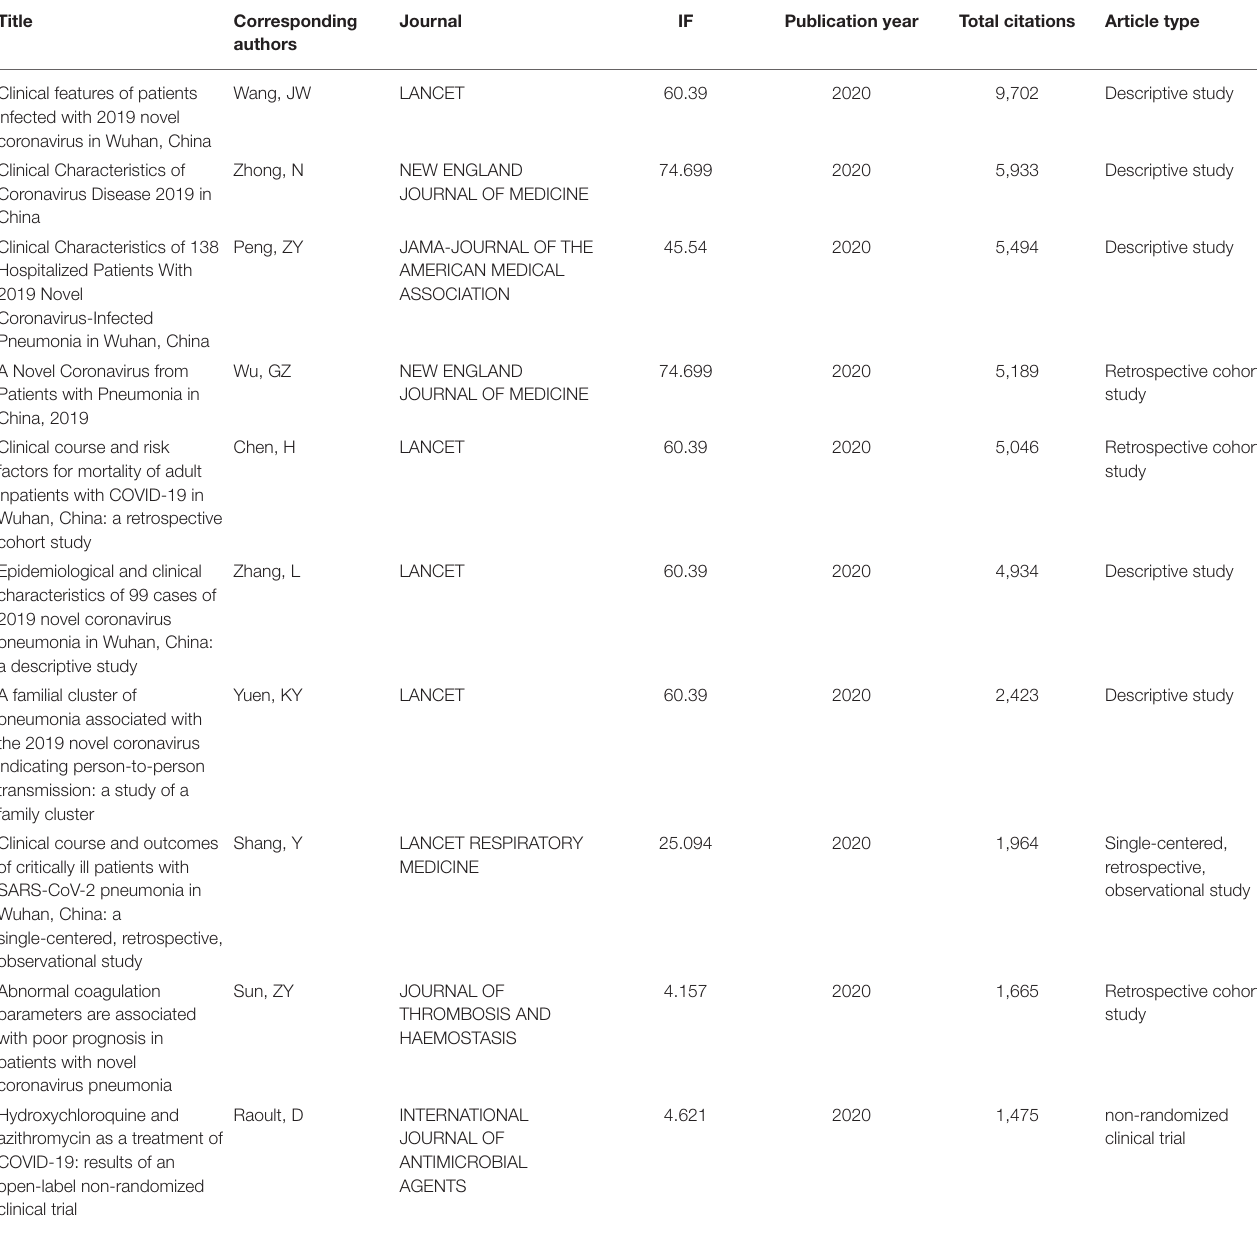
TABLE 1 | Top 10 most cited studies on coronavirus disease-2019